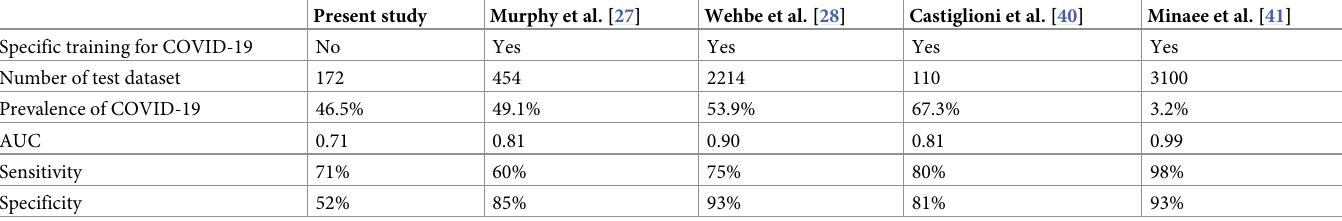
Table 5. Comparison of performance of CAD for identifying COVID-19 with results from different